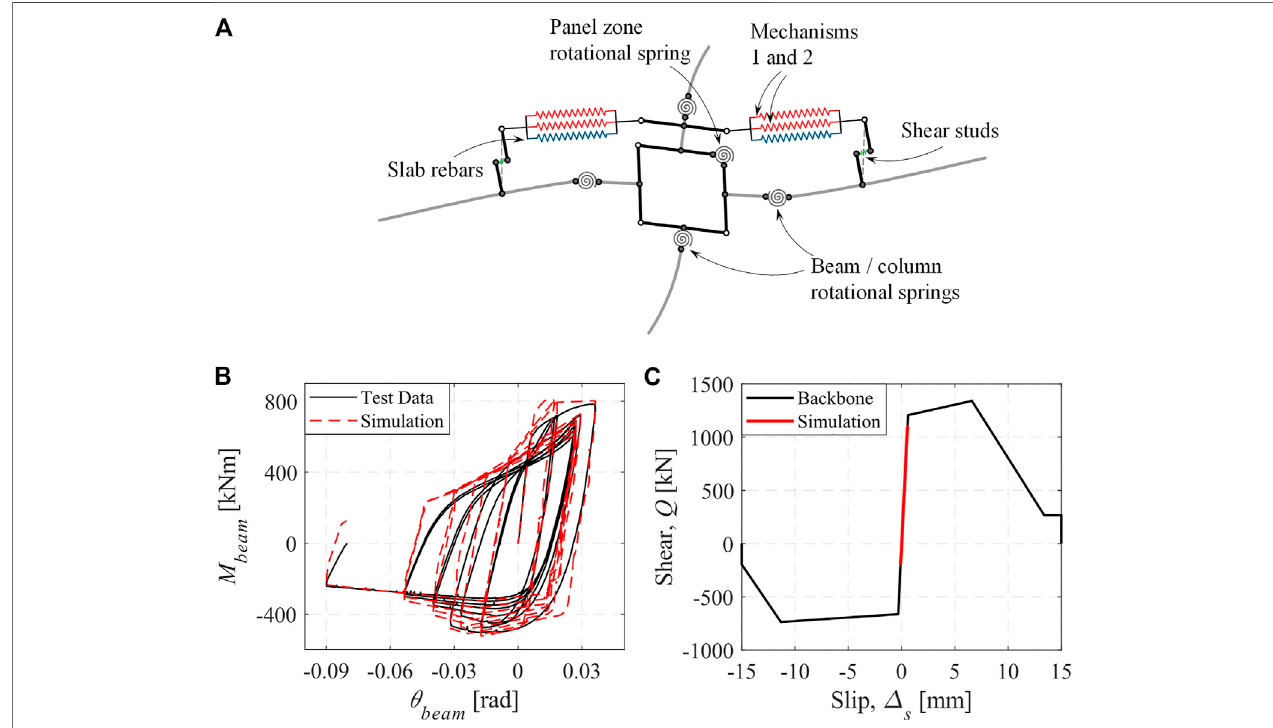
FIGURE 10 | Modeling approach implemented for the system-level response history analysis of the 6-story composite steel building (A) macro-model (B) model validation with Yamada et al. (2009) (C) shear-slip response of the beam-slab connection.